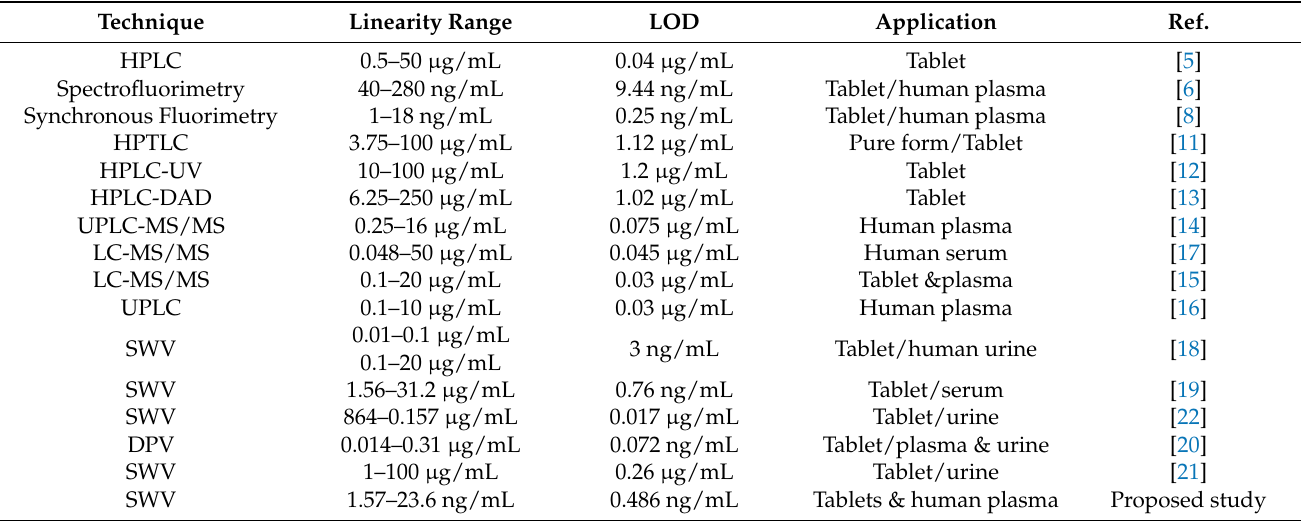
Table 5. Comparison between the proposed method for determination of FAV to previously reported